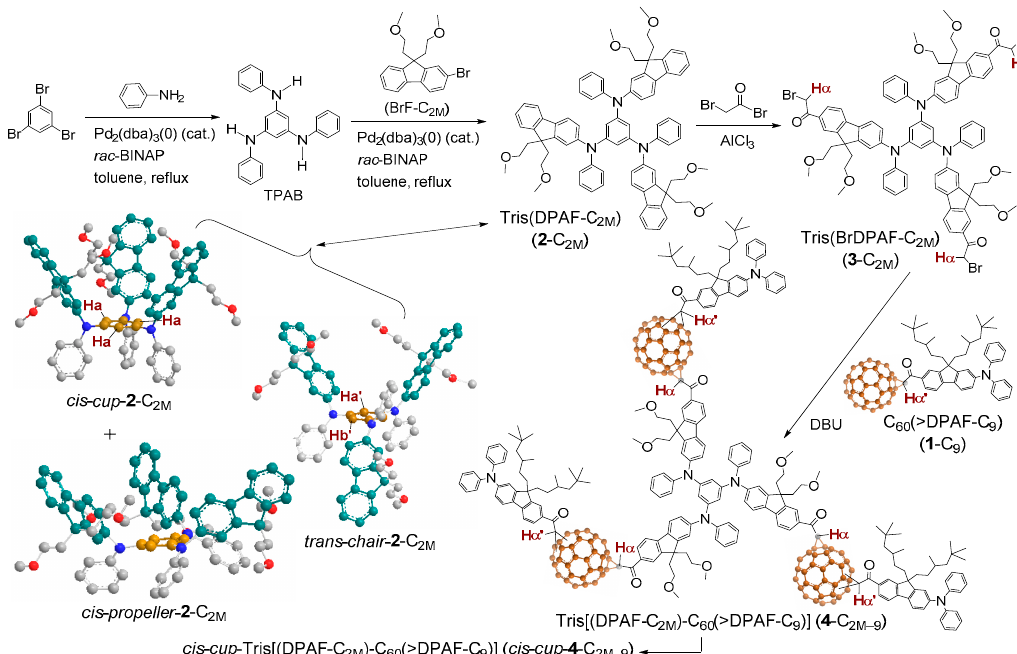
Figure 1. Synthetic methods for the preparation of 3D conformers of tris[(DPAF-C 2M )-C 60 (>DPAF-C 9 )] ( 4 -C 2M ‒ 9 ) with reaction reagents given and three perspective 3D-configurations of the key stereoisomeric intermediate 2 -C 2M .